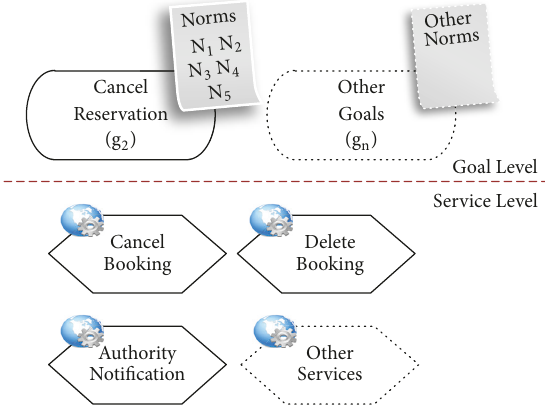
Figure 6: A subset of available services for Eurent case